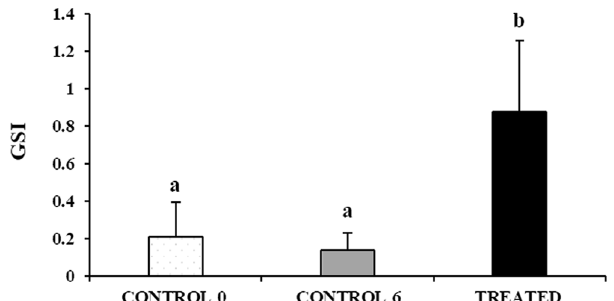
Figure 1. Mean (± sd) gonadosomatic index (GSI) of untreated (CONTROL 0, n = 5), treated with saline solution for 6 weeks (CONTROL 6, n = 9) or treated with rFsh for 6 weeks (TREATED, n = 4) juvenile meagre males. Different letters represent statistically significant differences (ANOVA; P <